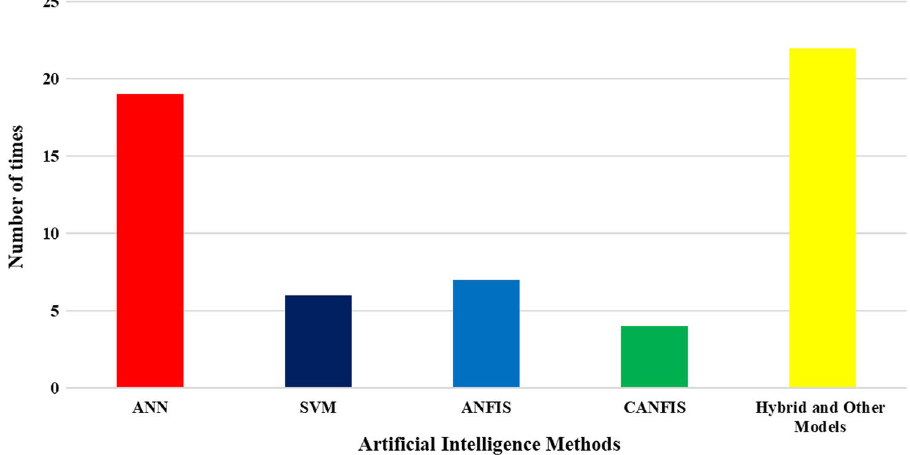
Fig. 2 Number of times that the AI methods have been used for predicting reservoir inflow and evaporation based on reviewed